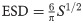
Morphologically diverse marine microbes.Length-to-width ratio versus surface-equivalent sphere diameter (ESD) [13] of some abundant free-living microbes in the upper ocean (S1 Table). Surface area (S) of ESD (ESD=6πS1/2) was calculated based on the assumption of a prolate spheroid [13]. Color of points shows average abundances. Dashed black line represents the length: width ratio of a perfectly spherical cell.